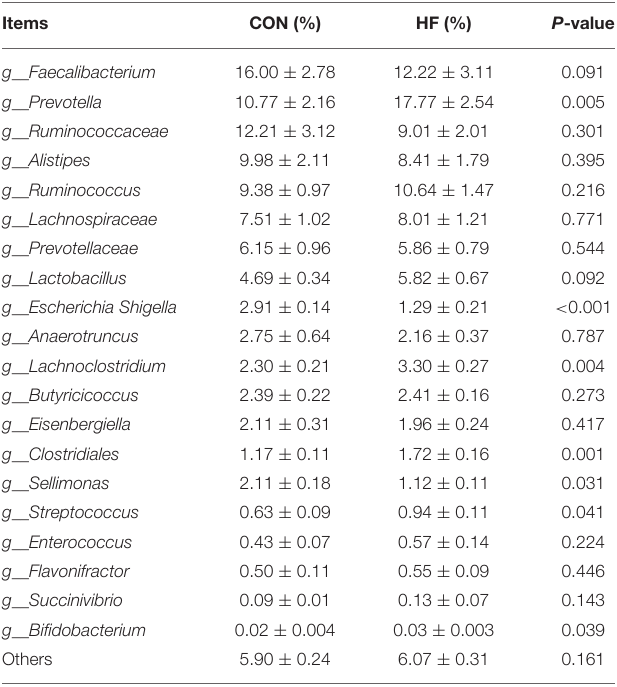
TABLE 7 | Effects of honeycomb flavonoids (0.5% of HF) on the relative abundances of cecal bacterial communities in the level of genus ( n =